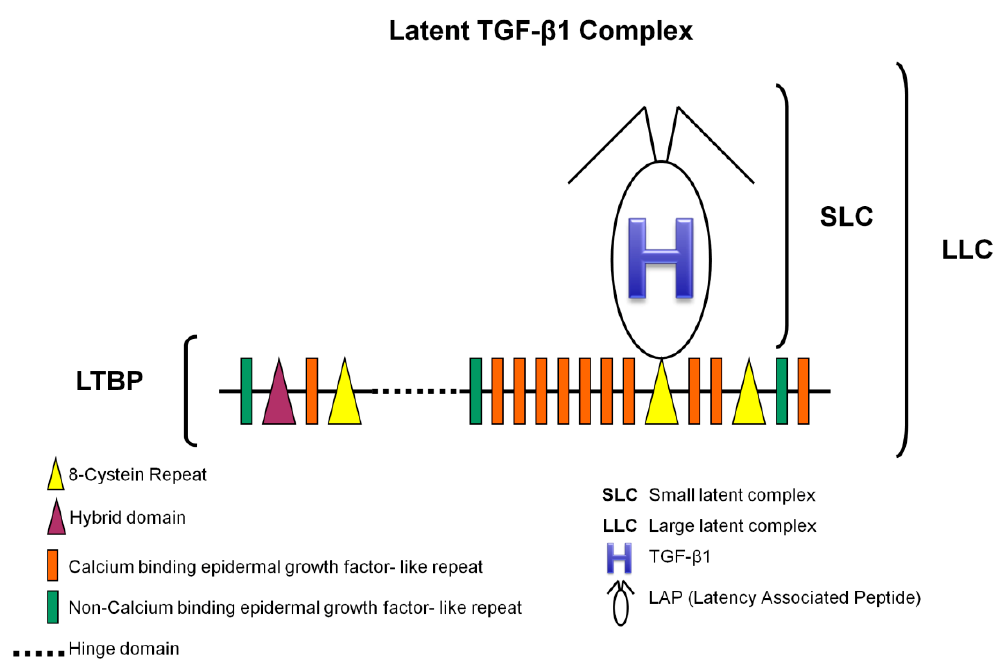
Figure 1. TGF- β 1 large latent complex. LLC is composed of (I) a mature TGF- β 1; (II) a latency associated peptide, which is a 75 kD homodimer with three side chains, two of which have the amino acid asparagine linked to mannose-6-phosphate oligosaccharides; and (III) a latent TGF- β binding protein of 125–160 kD, that contains 17 epidermal growth factor-like domains (14 of which are associated with calcium binding sequences) and four 70-amino-acid modules with eight cysteines each (adapted with permission from figure 1 in Rifkin DB. Latent transforming growth factor-beta [TGF-beta] binding proteins: Orchestrators of TGF-beta availability. J. Biol. Chem. 2005 , 280 , 7409–7412 [48]).